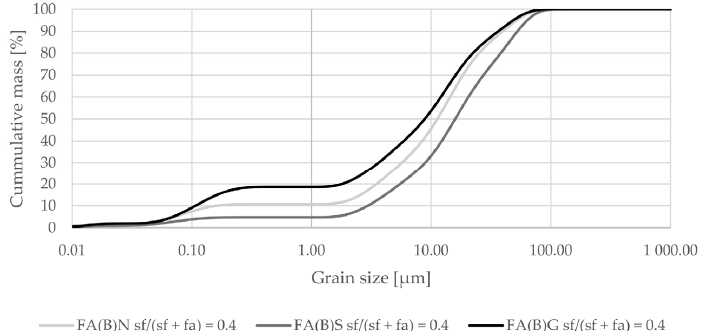
Figure 3. Grain-size distribution of fly ash activated by the addition of 40% of silica fume compared to the grain-size distribution of untreated fly ash (logarithmic scale).